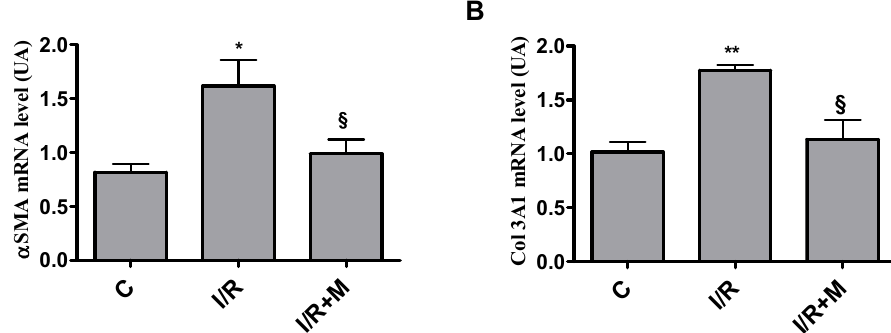
Figure 2. Metformin attenuates cardiac fibrosis in postinfarcted myocardium. Metformin treatment prevents fibrotic remodeling in postinfarcted myocardium. ( A ) Representative images of Sirius Red staining of frozen heart tissue sections from vehicle- or metformin-treated mice subjected to 30 min of cardiac ischemia and 14 days of reperfusion. Metformin treatment (5 mg/kg, i.p.) started 15 min after the onset of reperfusion and continued for 14 days. ( B ) Quantification of fibrotic area from ( A ), n =4–5. Data are presented as mean ± SEM. One-way ANOVA followed by Bonferroni’s post hoc test: ** p < 0.01 vs. control (C), § p < 0.001 vs. I/R.